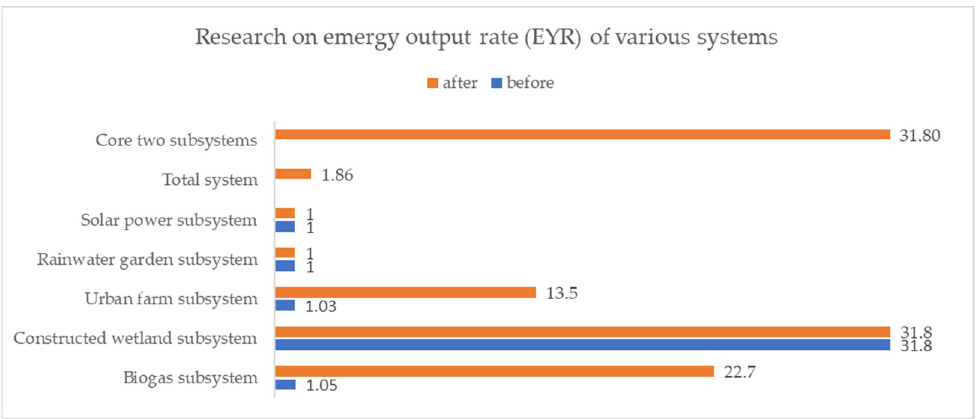
Figure 9. Research on emergy output rate (EYR) of various systems.